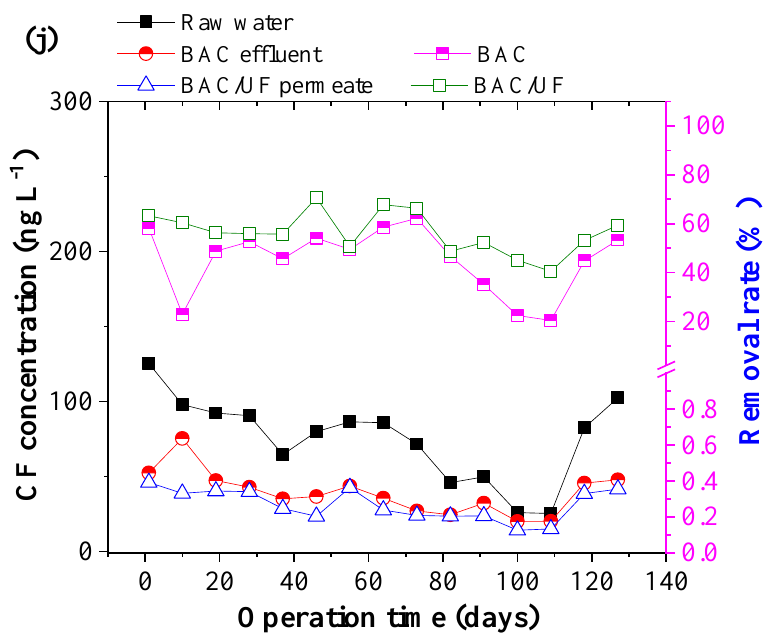
Figure 5. Removal performance of typical PPCPs by BAC-UF system: ( a ) EM, ( b ) EA, ( c ) SM2, ( d ) SMX, ( e ) SMP, ( f ) SMD, ( g ) SCP, ( h ) SDZ, ( i ) TMP, ( j ) CF.